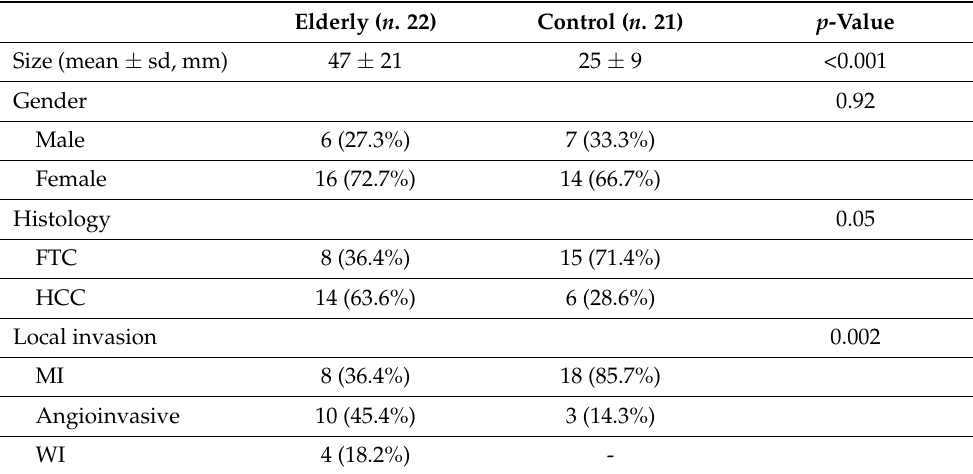
Table 4. Follicular and Hürthle cell carcinoma. Differences in pathological features between follicular and oncocytic tumors in elderly and control patients. Elderly ( n . 22) Control ( n .